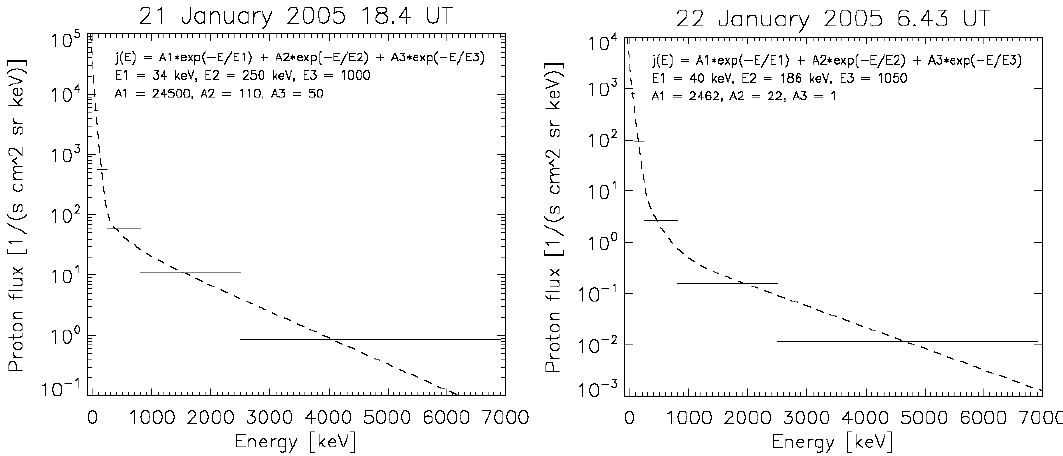
Fig. 7. The horizontal lines show the proton flux in five energy channels, 30–80keV, 80–240keV, 800–2500keV, and 2500–6900keV above Andøya retrieved by interpolating measurement from the MEPED detectors on NOAA 15, 16, and 17 on 21–22 January 2005 at two selected times. The dashed line is the proton energy spectra fitted to the flux in five energy